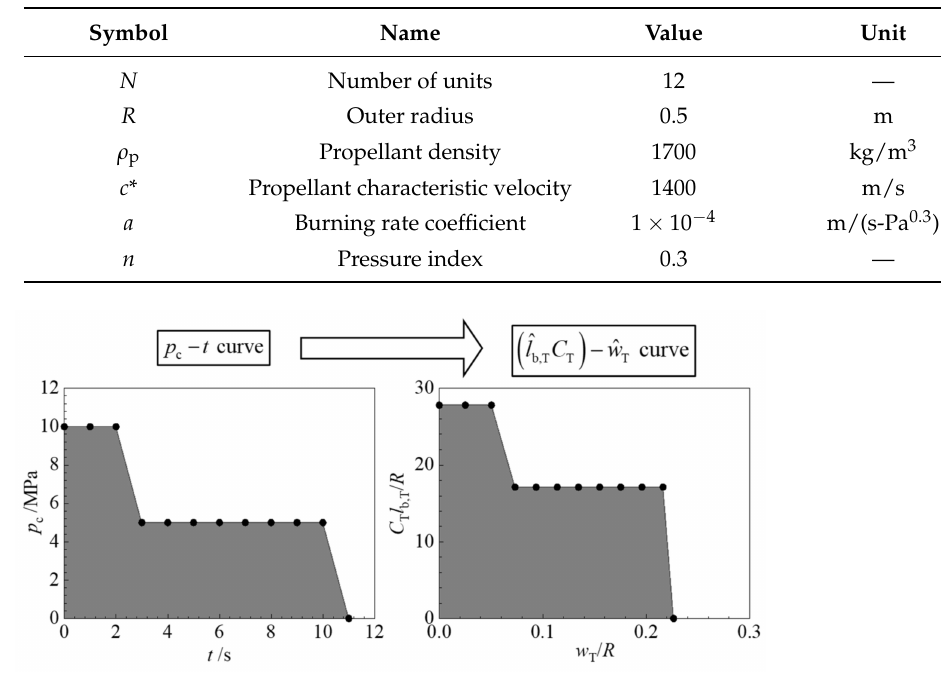
Figure 25. Reverse internal ballistic calculations of the dual-thrust